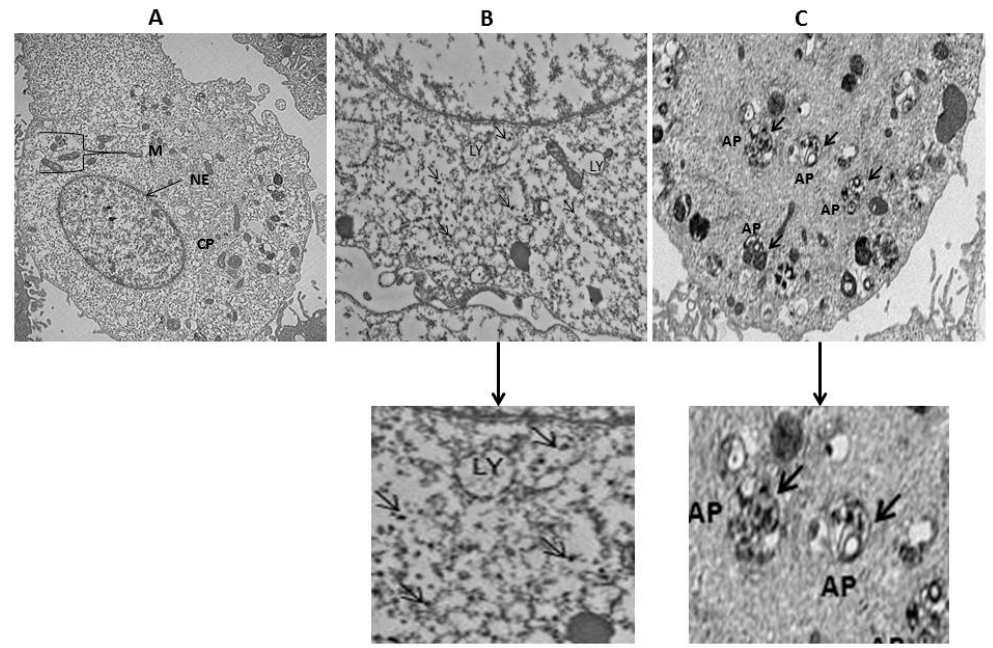
Figure 6. Intracellular localization of AgNPs and accumulation of autophagosomes and autolysosomes. NIH3T3 cells were treated with silver nanoparticles (AgNPs) for 24 h and then processed for transmission electron microscopy (TEM) sections. TEM images of NIH3T3 cells without AgNPs ( A ); internalization of AgNPs (thin black arrow) ( B ); and AgNPs induces accumulation of autophagosomes (thick black arrow) ( C ). M—Mitochondria; NE—Nuclear envelope; CP—Cytoplasm; LY—lysosomes; AP—Autophagosomes, scale bar: 2 µm.